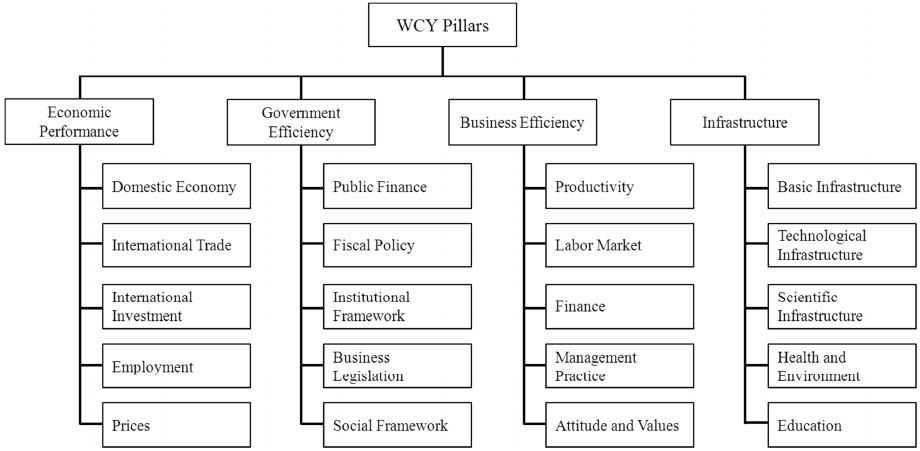
Figure 2 – Four pillars of